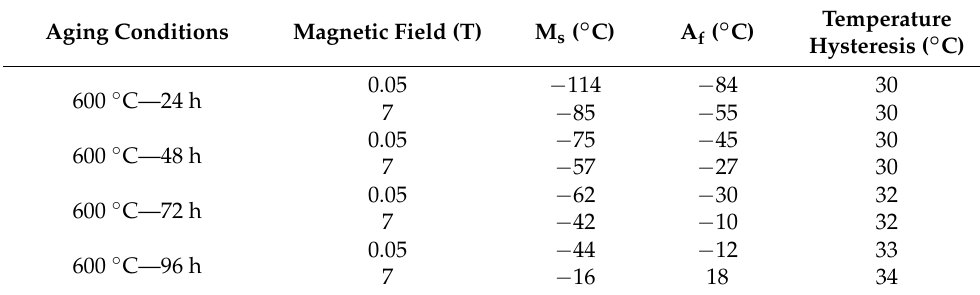
Table 3. Martensitic transformation temperatures and temperature hysteresis in aged FeNiCoAlTiNb samples under 0.05 Tesla and 7 Tesla. Aging